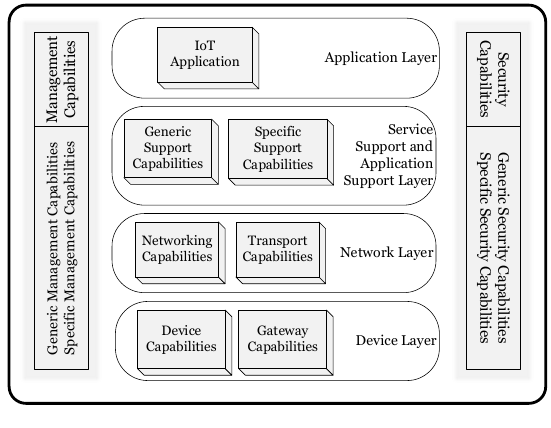
Figure 3. ITU-T reference model [45].